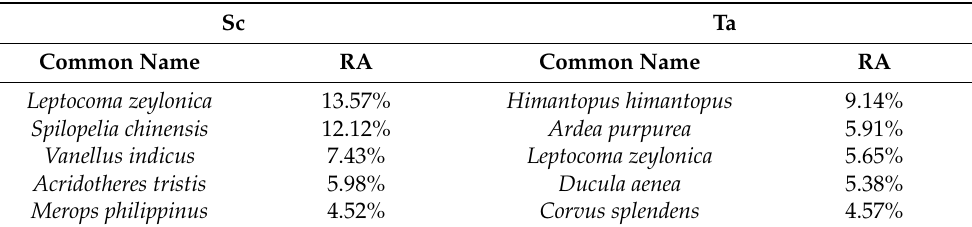
Table 5. List of the five most abundant bird species, in order of relative abundances, in the Sc and Ta habitats. For habitat labels, cf. Table 1. RA stands for Relative